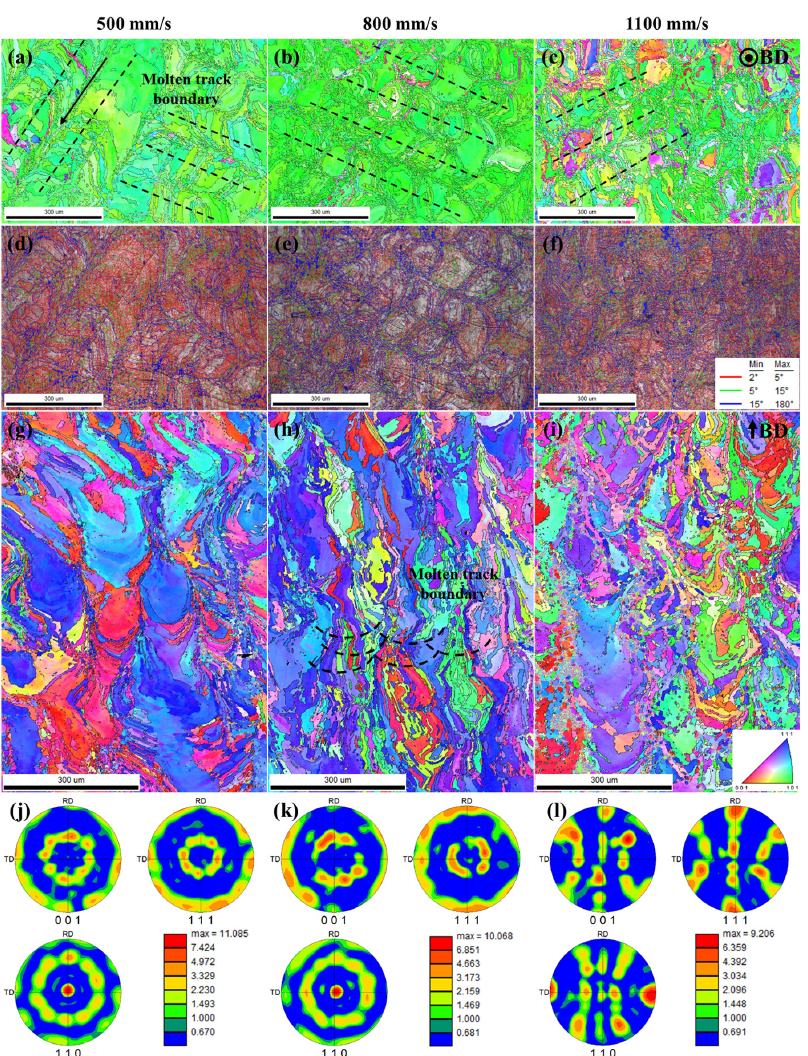
Figure 7. EBSD analysis results of Cu–Cr–Nb–Ti alloy samples manufactured by different scanning speeds (laser power of 325 W): ( a – c ) are IPFs of XY planes of samples manufactured by 500 mm/s (P 325 V 500 ), 800 mm/s (P 325 V 800 ), and 1100 mm/s (P 325 V 1100 ) (the black dotted line is the boundary of the molten track, and the arrow is the laser moving direction); ( d – f ) are the IQ maps of XY planes of samples; ( g – i ) are IPFs of XZ planes of samples; ( j – l ) are the PFs of XY planes of